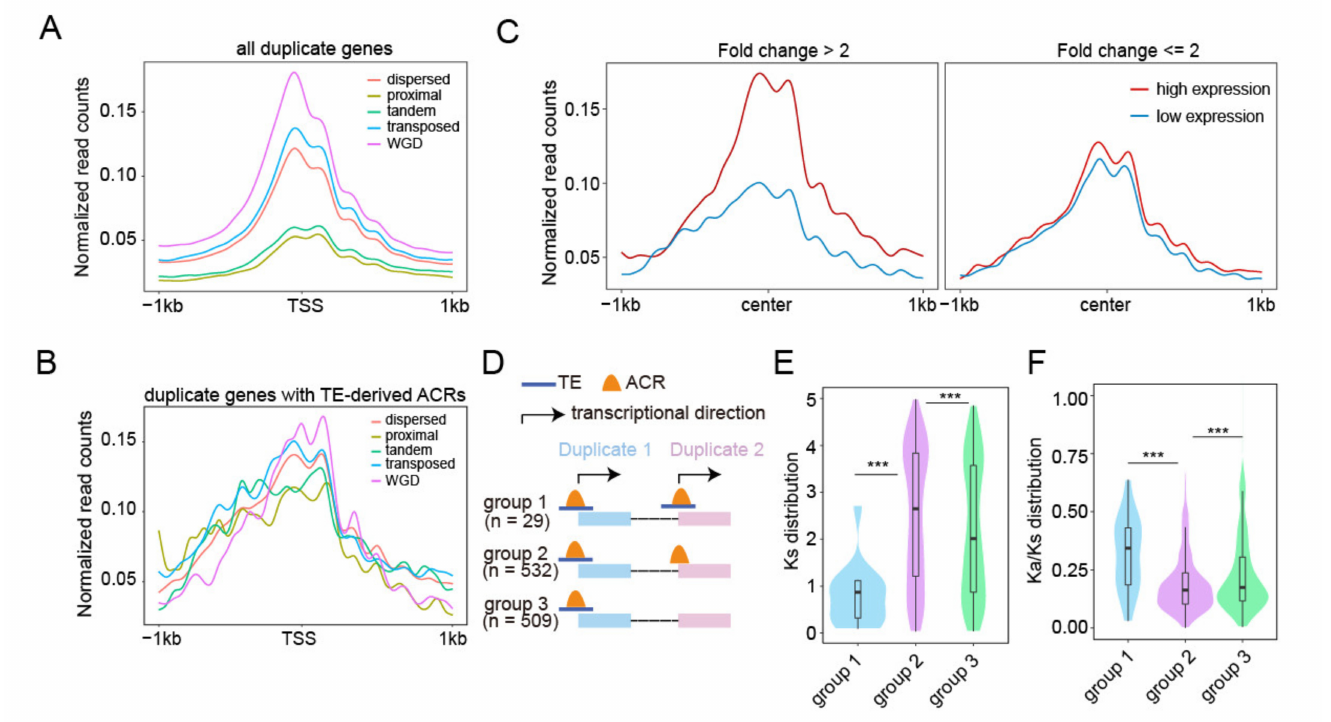
Figure 5. The chromatin accessibility for duplicated gene pairs. ( A ) Genome-wide normalized ATAC- seq read density of WGD, transposed, tandem, proximal, dispersed duplicated genes. ( B ) Normalized ATAC-seq read density of duplicated genes associated with TE-derive ACRs. ( C ) Correlation between chromatin accessibility changes and gene expression changes of duplicated gene pairs corresponding to TE-derive ACRs. All gene pairs were divided into two groups according to their expression differences: fold change > 2 and fold change <= 2, the chromatin accessibility variations showing greater differences in the fold change > 2 group. ( D ) Gene pairs with TE-derived ACRs around TSSs were divide into three subgroups. Only 29 pairs of duplicated genes had TE-derived ACRs around TSSs of both copies. ( E , F ) Comparisons of distributions of Ks ( E ) and Ka/Ks ( F ) between duplicated gene pairs in three groups are illustrated in ( D ). Significance test was determined using Wilcoxon rank sum test, *** p <